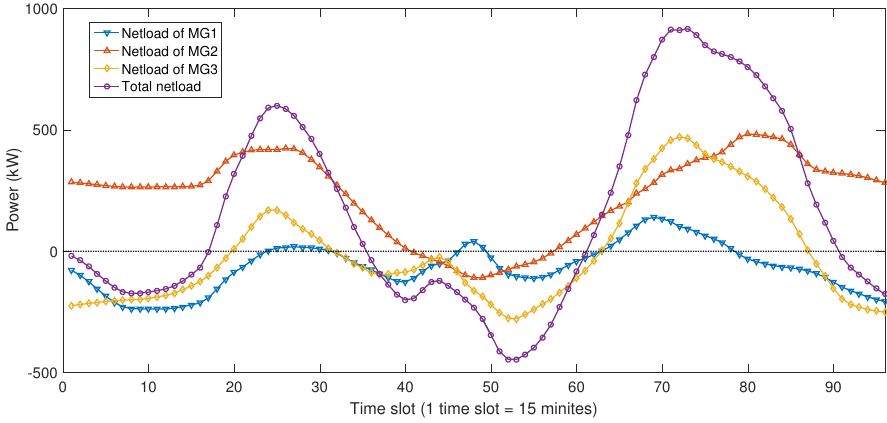
Figure 5. Net power curves of the